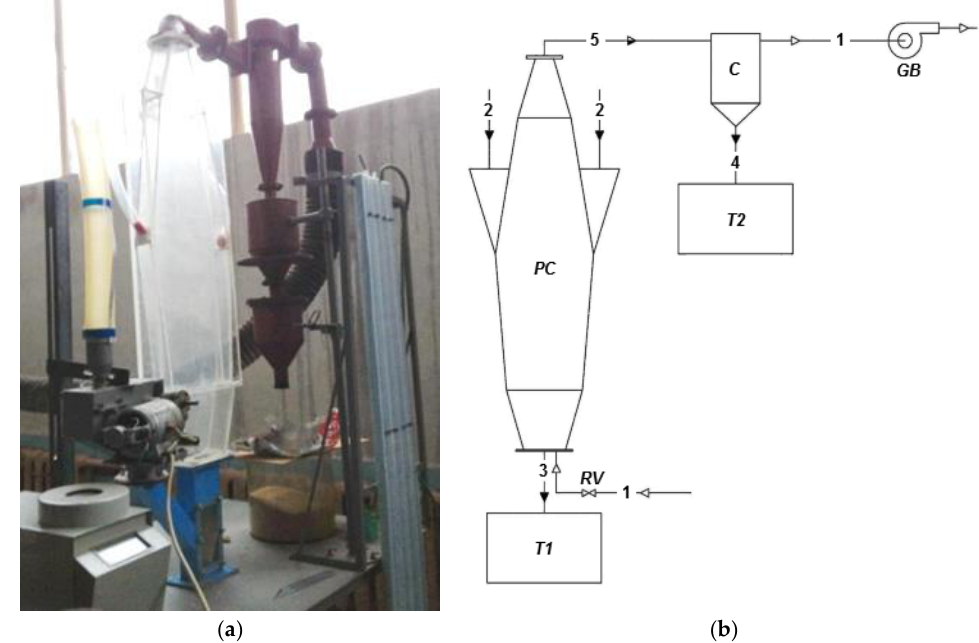
Figure 3. Experimental stand ( a ) and its technological scheme ( b ) for studying the process of pneumatic classification: 1 — air flow; 2 — outlet mixture; 3 — coarse fraction; 4 — fine fraction; 5 — air classification: 1—air flow; 2—outlet mixture; 3—coarse fraction; 4—fine fraction; 5—air flow with flow with a fine fraction; C — cyclone; PC — pneumatic classifier; GB — gas blower for creation of a suction flow; T1 — tank for collecting a coarse fraction; T2 — tank for collecting a fine fraction; RV — regulating valve.